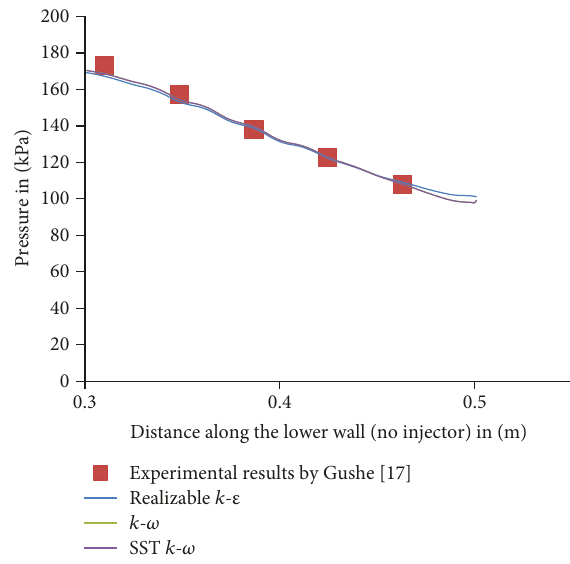
Figure 6: Comparison between numerical results and experimental data for static pressure distribution along the lower wall using di ff erent turbulence